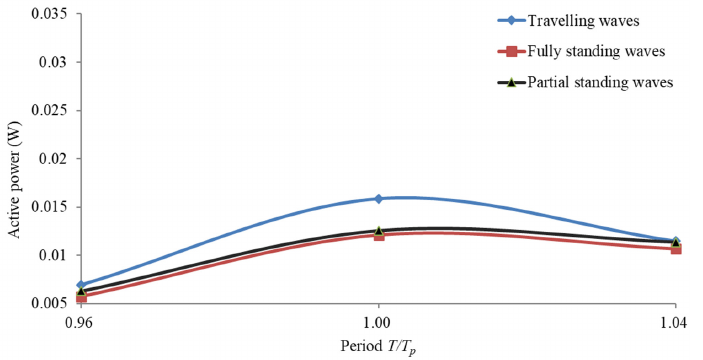
Figure 25. Comparison of generation performance under three different wave types at h = 0.8 m.